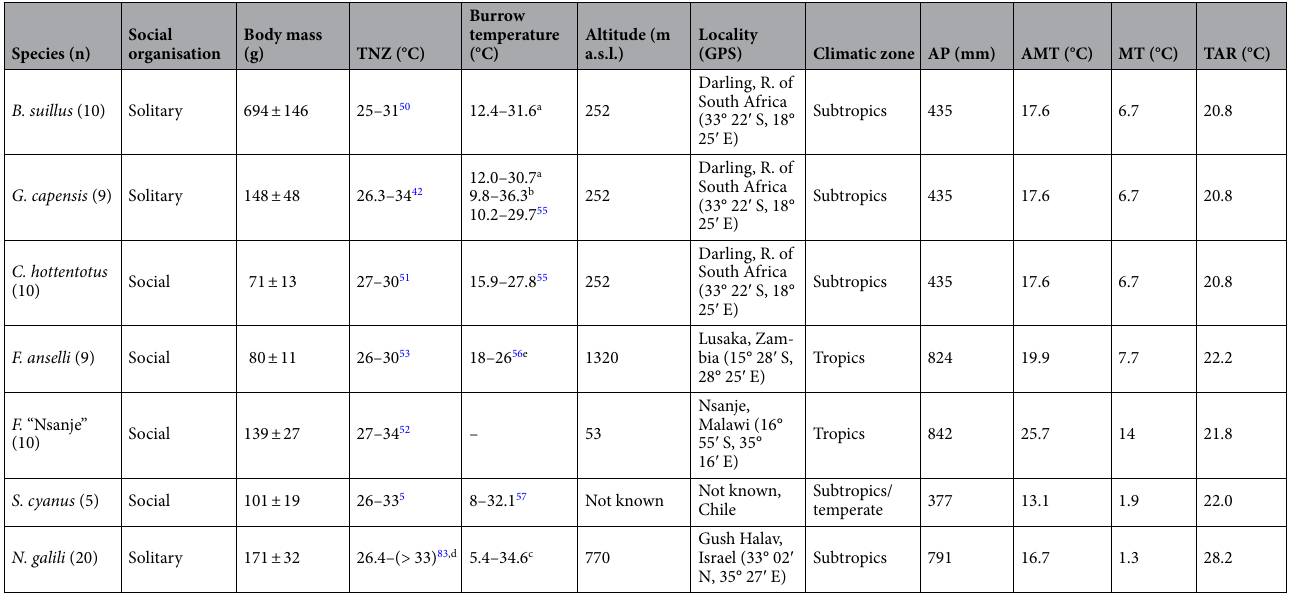
Table 1. Characteristics of seven studied species of subterranean rodents and their habitats. Means ± SD of body masses are given. Numbers in parentheses after the species names represent sample sizes. TNZ, thermoneutral zone; AP, annual precipitation; AMT, annual mean temperature; MT, minimal temperature; TAR, temperature annual range (climatic parameters were downloaded from the Worldclim database 49 ; due to the unknown locality of S. cyanus , climatic data from the whole species range were used). a J.